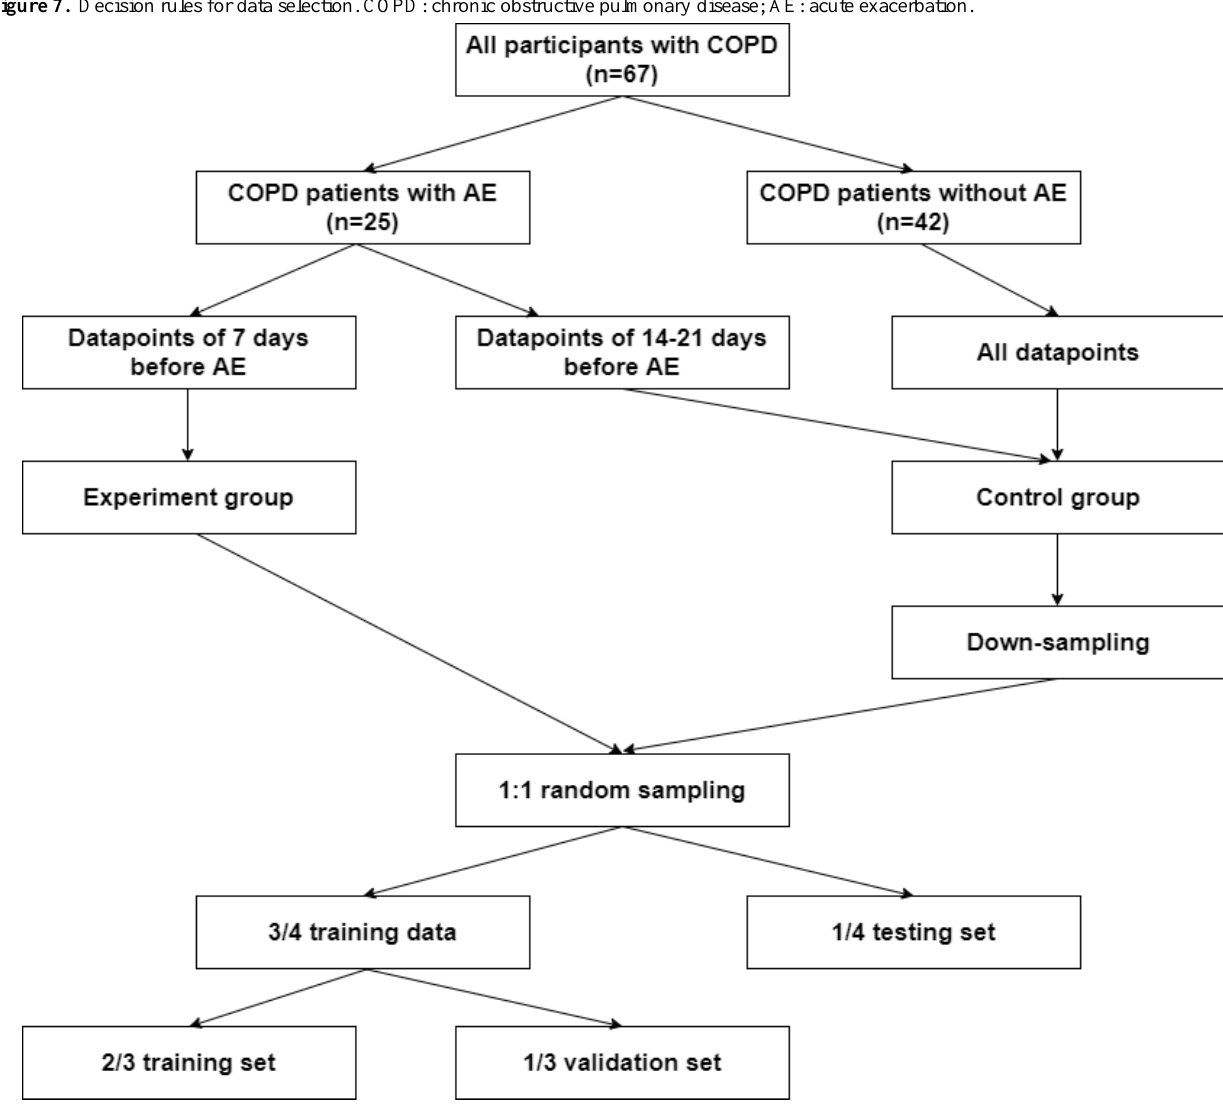
Figure 7. Decision rules for data selection. COPD: chronic obstructive pulmonary disease; AE: acute